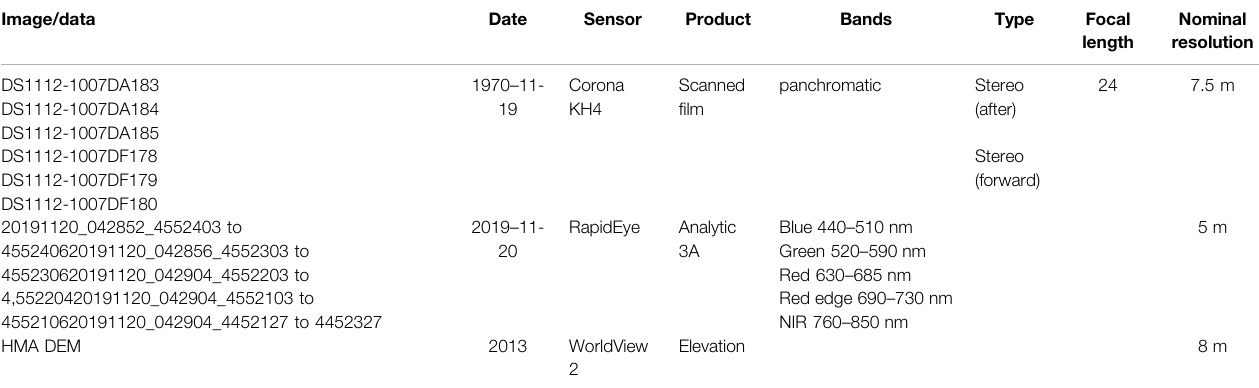
TABLE 1 | Satellite data used in this study and their